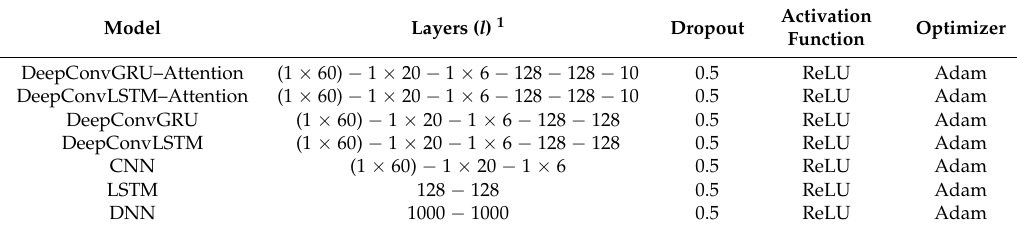
Table 2. Hyper-parameters of models on Ocslab driving dataset.